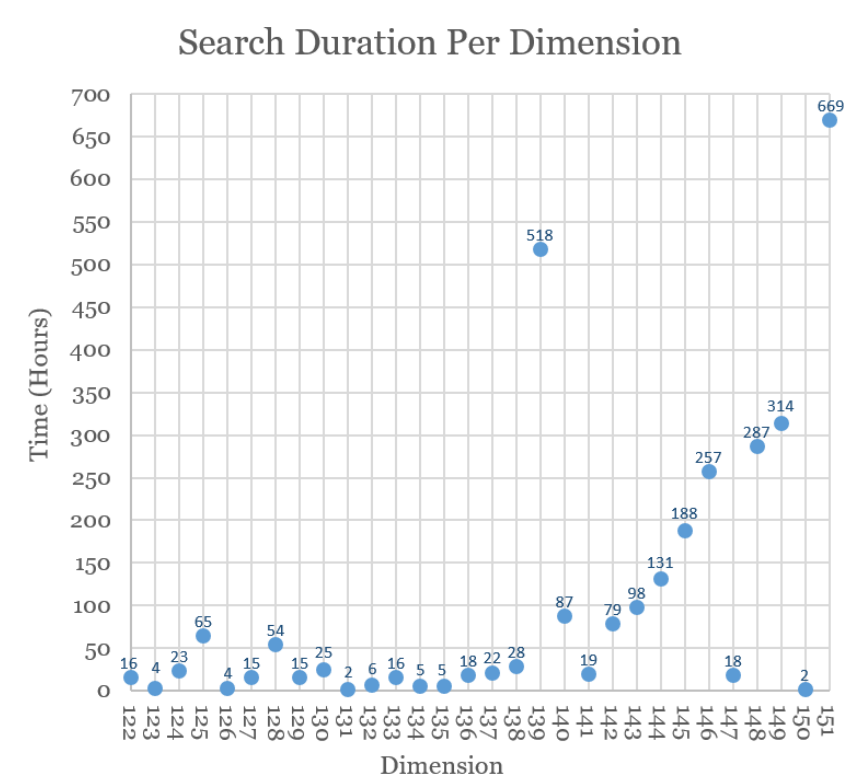
Figure 1. Time (in hours) spent searching for a Weyl–Heisenberg SIC in dimensions 122 through